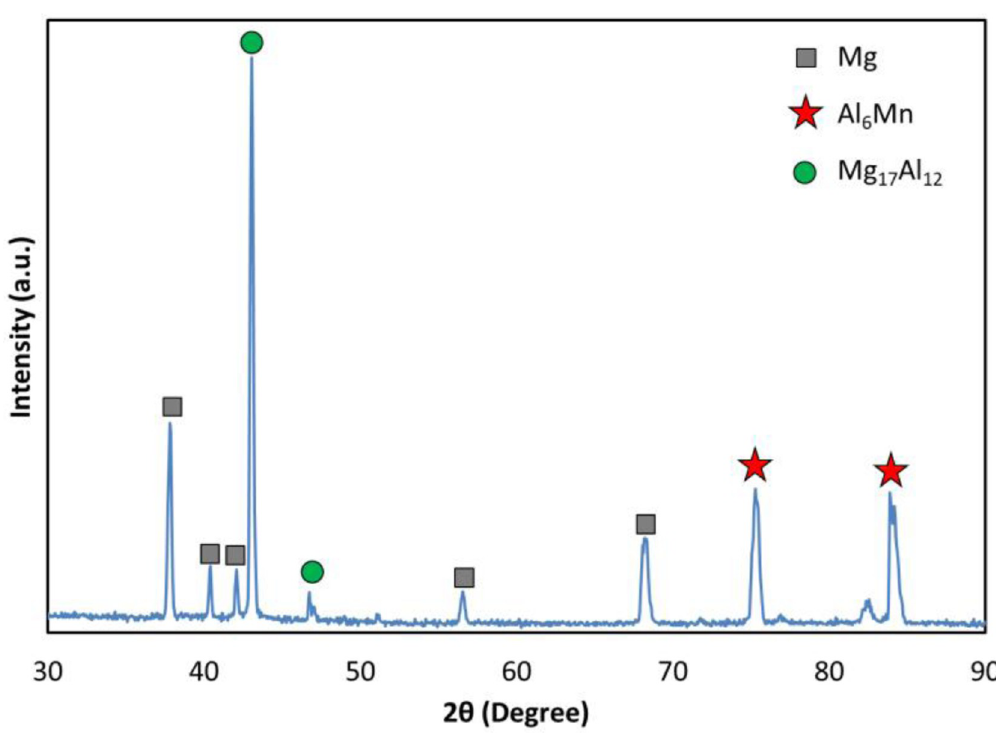
Fig 3. The XRD pattern for the AM60 magnesium alloy.